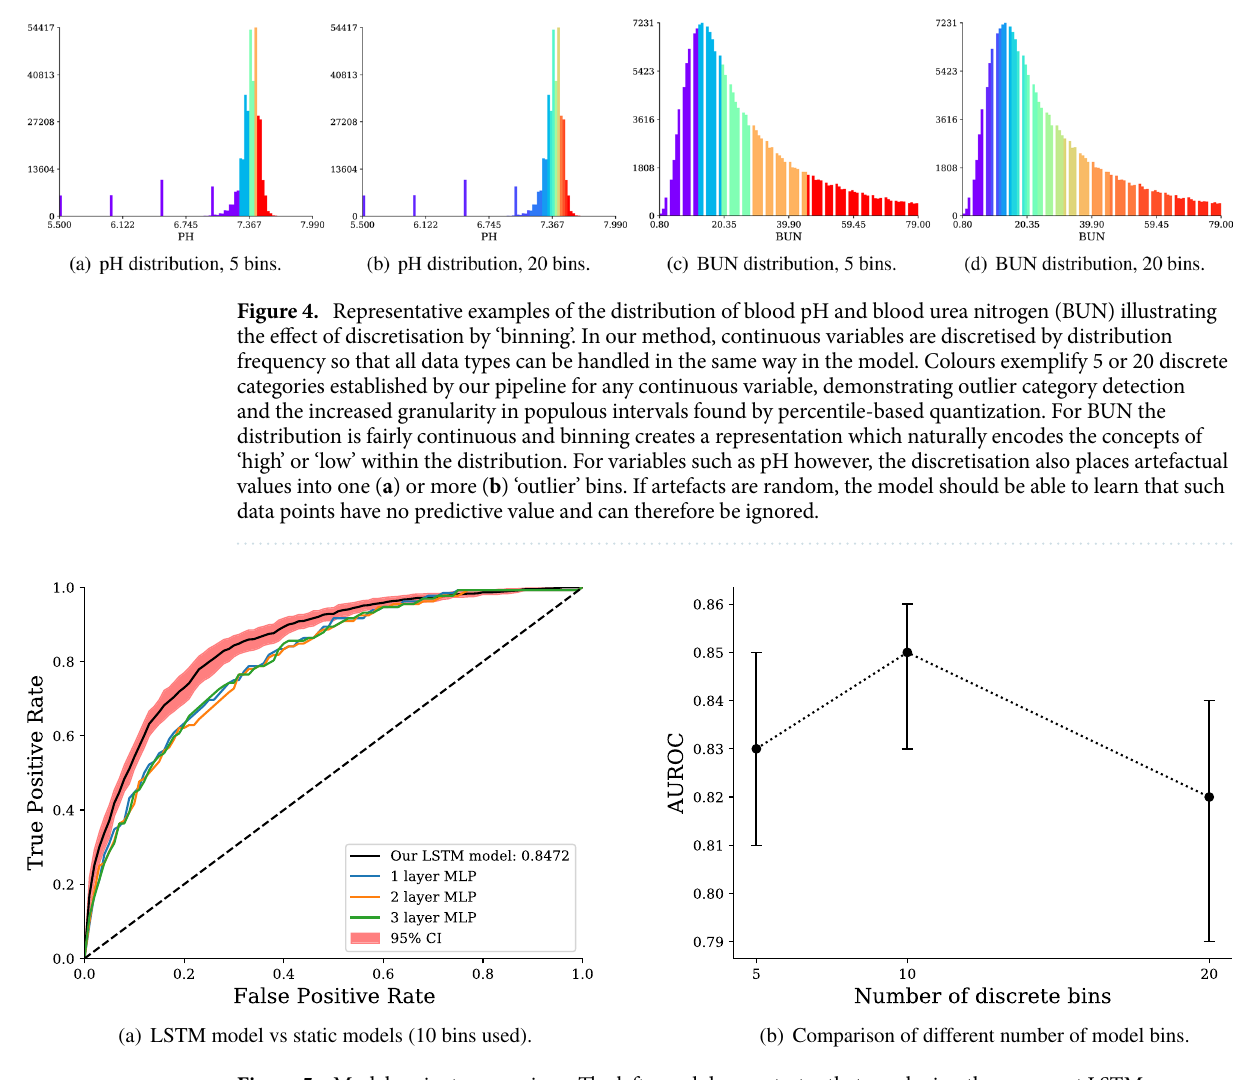
Figure 5. Model variant comparison. The left panel demonstrates that employing the recurrent LSTM architecture after the model embedding layer leads to a significant increase in model performance. The right panel depicts the impact of differing the number of continuous value percentile bins. When considering 5, 10, and 20 bins, we find that 10 offers the best performance and use this in all other results. 95% Confidence intervals are bootstrapped from a 10-fold cross-validation using 10,000